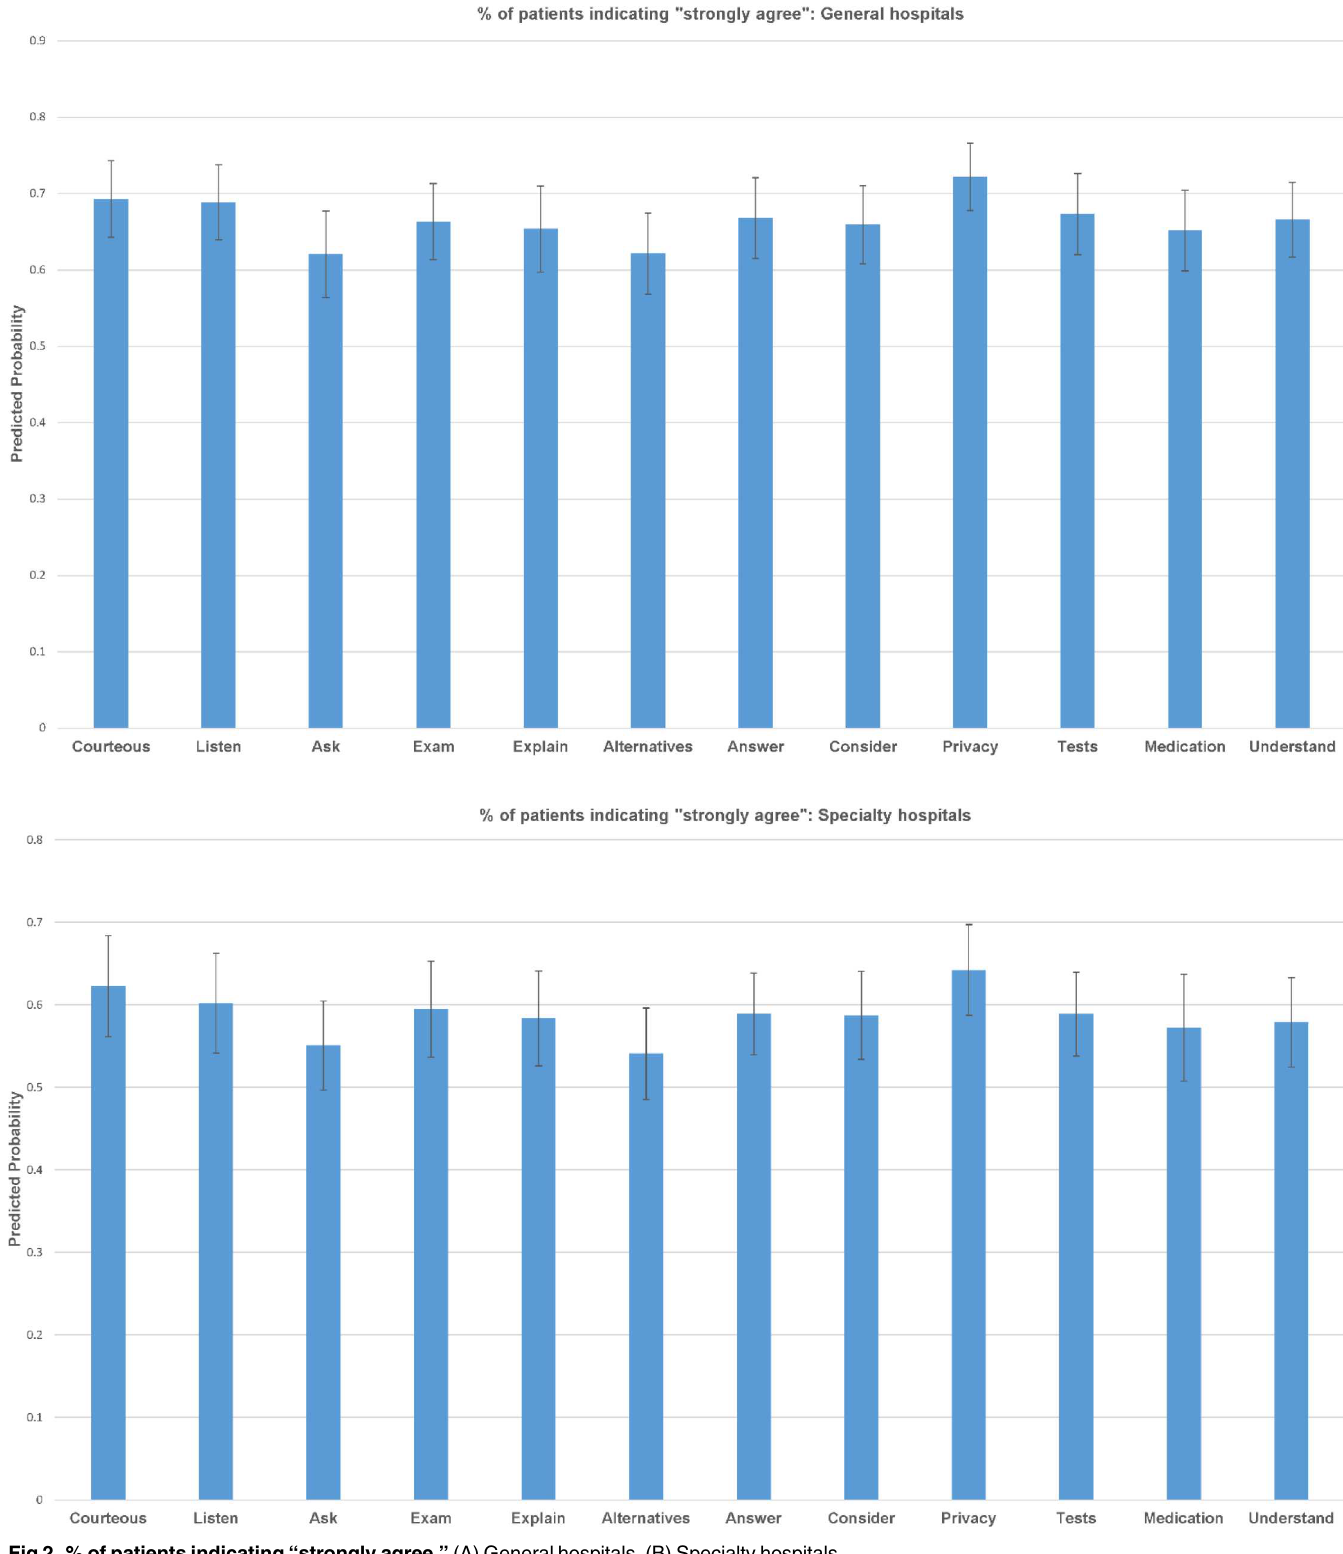
PLOS ONE | DOI:10.1371/journal.pone.0171684 February 16,